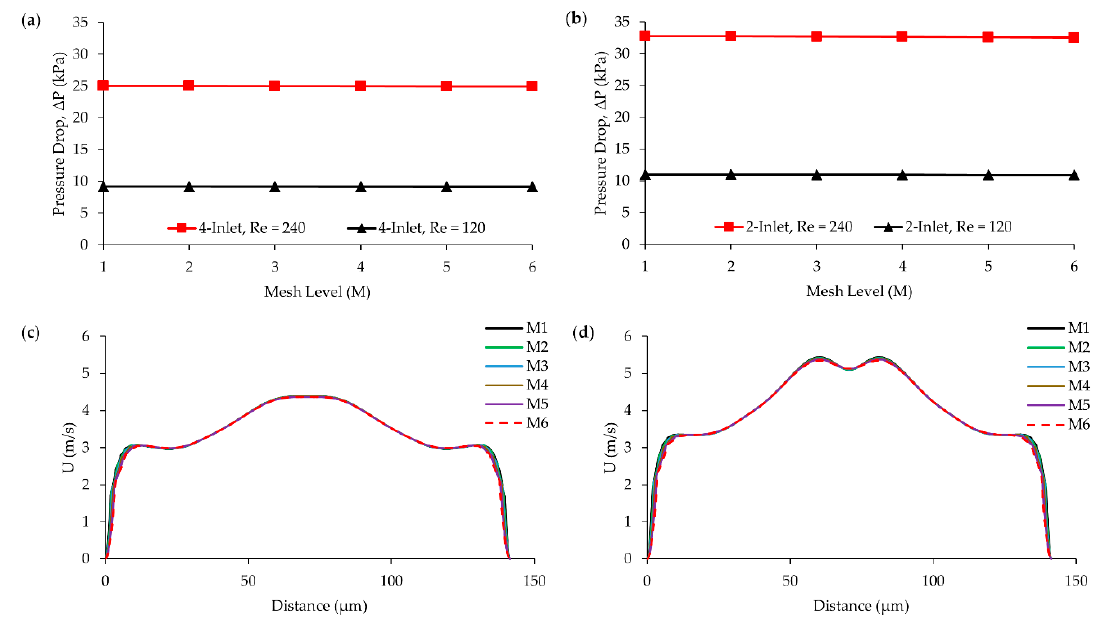
Figure 5. Grid study results for fluid flow: ( a ) and ( b ) pressure drop in micromixers at Re = 240 and 120 for four-inlet and two-inlet designs respectively; ( c ) and ( d ) velocity distribution on x-y plane at the exit of mixing box (Line-I in Figure 3) at Re = 240 for four-inlet and two-inlet designs respectively.